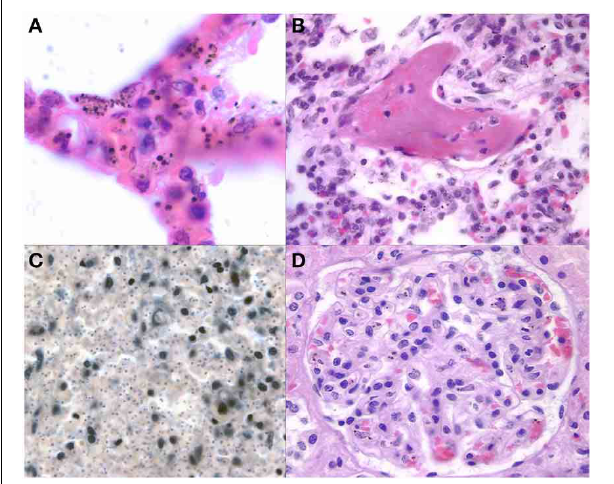
FIGURE 7 | Representative images of pathology outside of the brain are shown. The lungs (A) demonstrate some sequestration of parasites but more frequently have heavily burdened macrophages with variable size pigment globules (1000X, H&E). Fibrin thrombi (B) were present in a subset of CM2 and other cases in the lungs suggestive of DIC (400X, H&E). The spleen (C) in a patient with CM after depigmentation of the section using picric acid followed by Giemsa stain (from Milner, unpublished data) demonstrating the unique finding of dense parasite burdens in CM1 spleens (200X, Giemsa). A representative glomerulus (D) from the kidney shows malaria pigment within macrophages and microthrombi present in capillaries (400X,